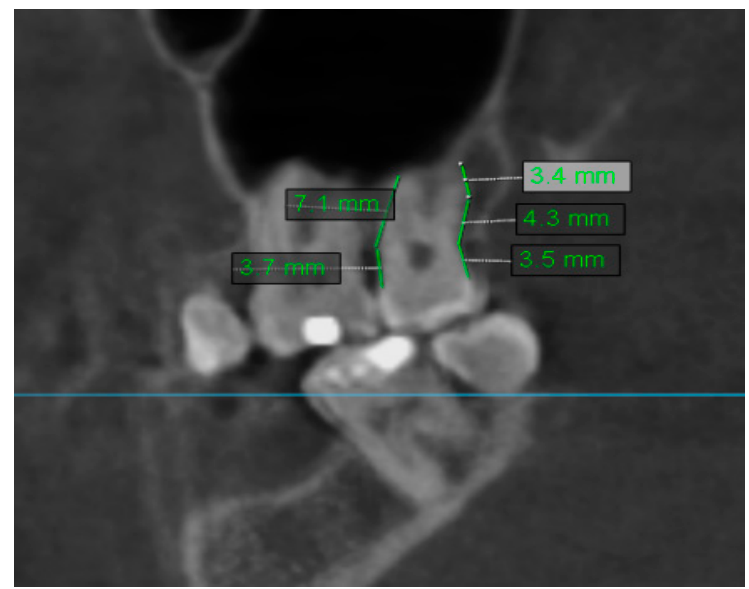
Figure 9. Sample measurement of periodontal bone loss.